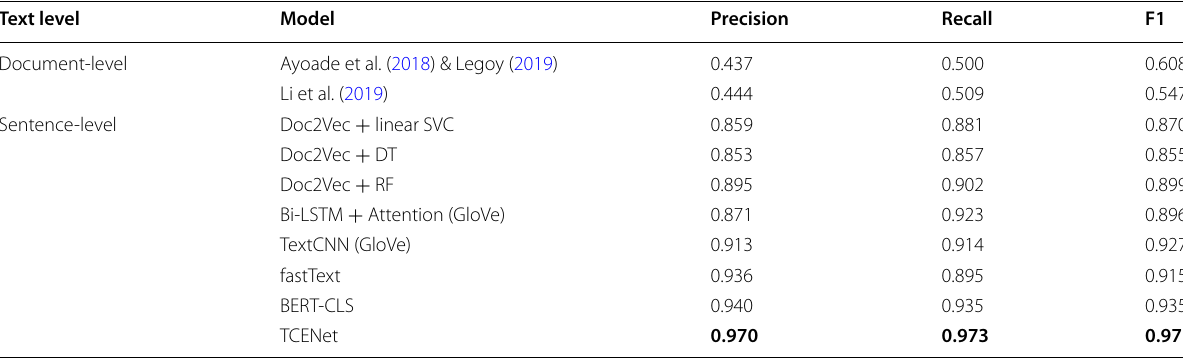
The best classification result is shown in bold font